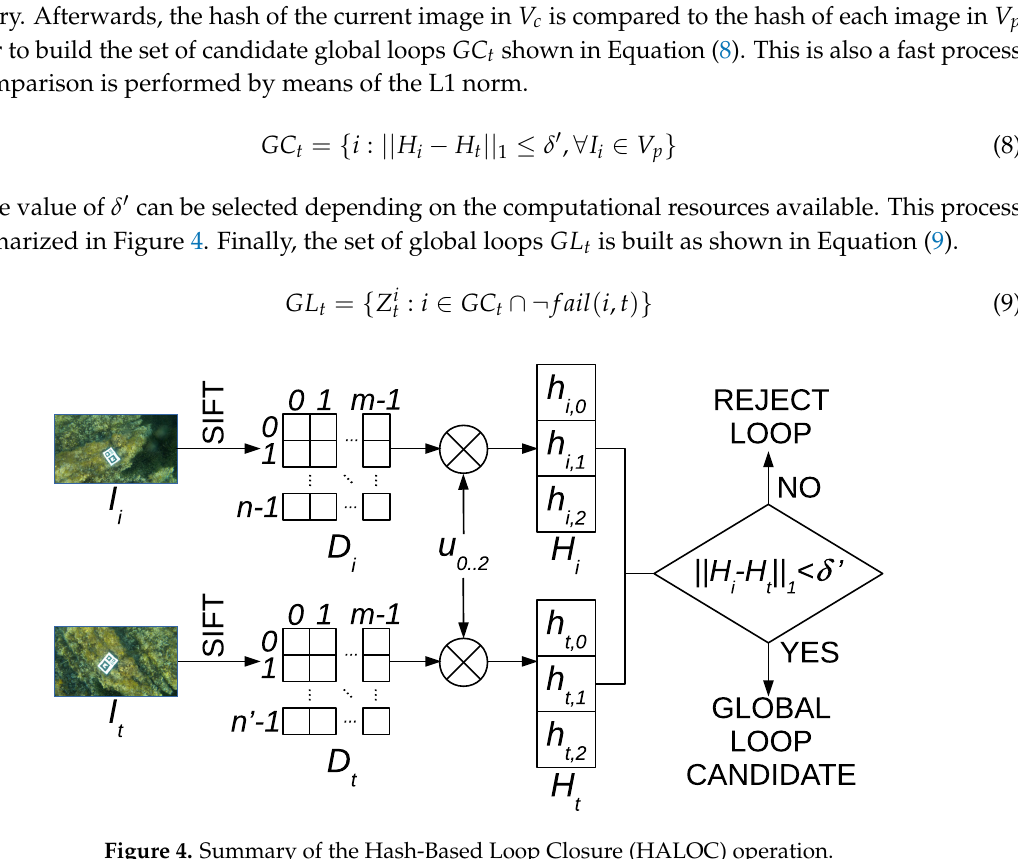
Figure 4. Summary of the Hash-Based Loop Closure (HALOC)